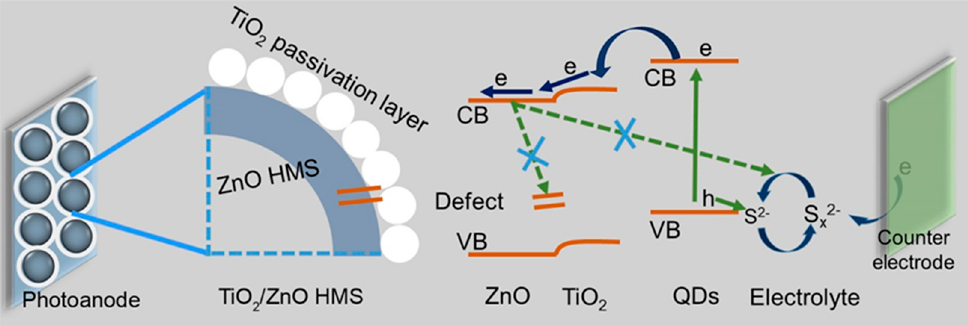
Figure 10. The illustration of charges deliver and recombination process on interfaces of TiO 2 @ZnO HMS-based QDSSC.